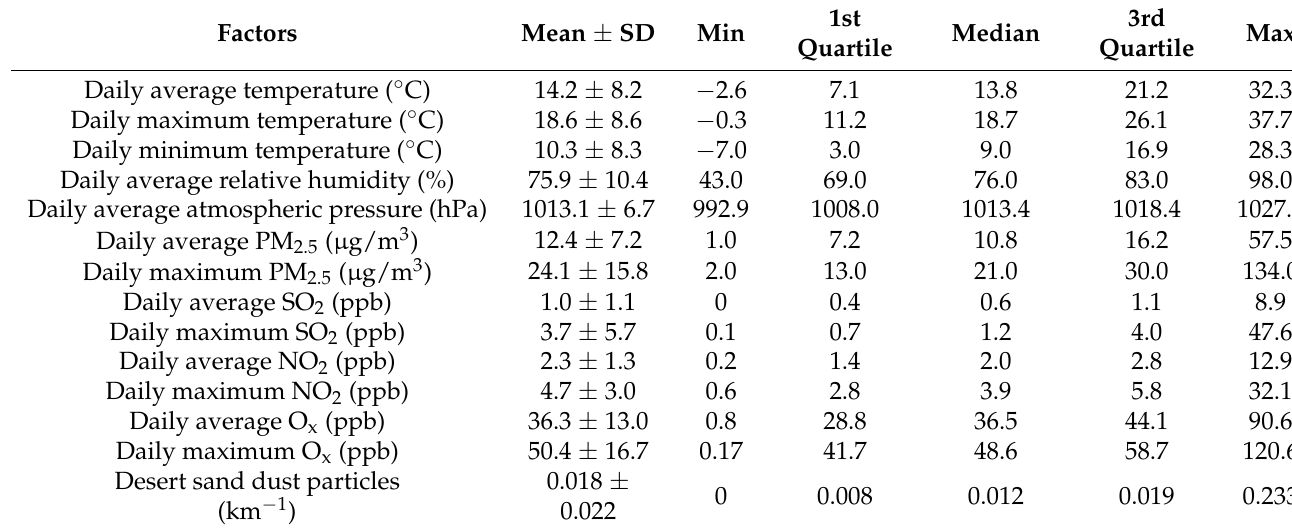
Daily maximum O x (ppb) Desert sand dust particles